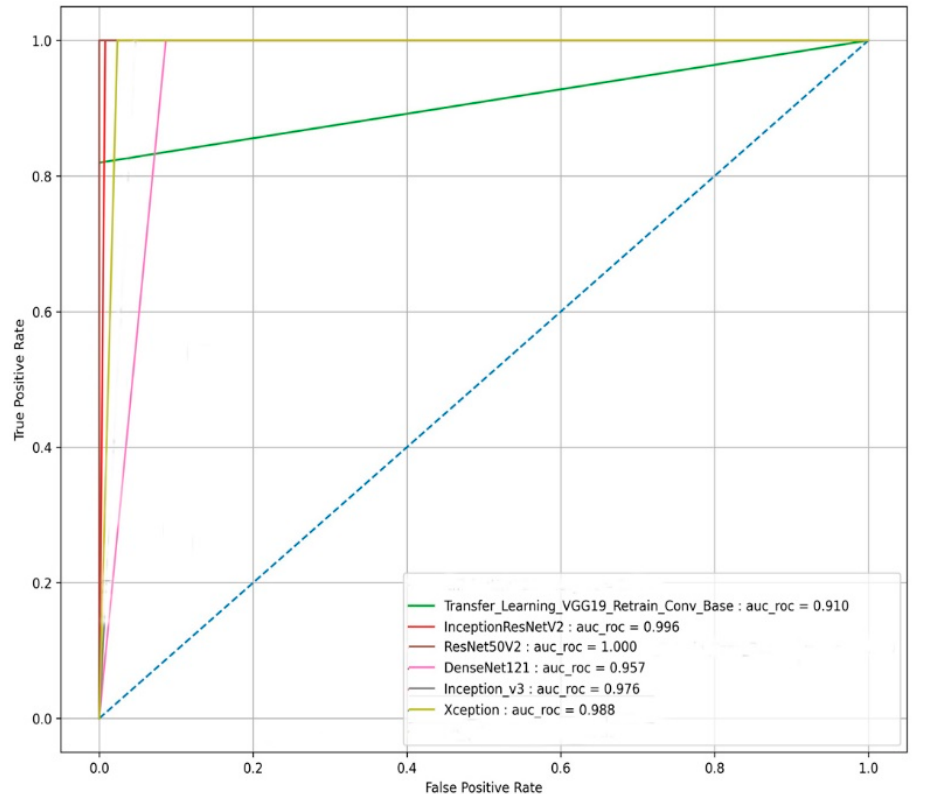
Figure 11. The ROC_AUC curve ‐ based performance comparison of the six state ‐ of ‐ the ‐ art transfer learning models for the image ‐ based classification of the fibrosis and normal classes from the testing CT scan image dataset.